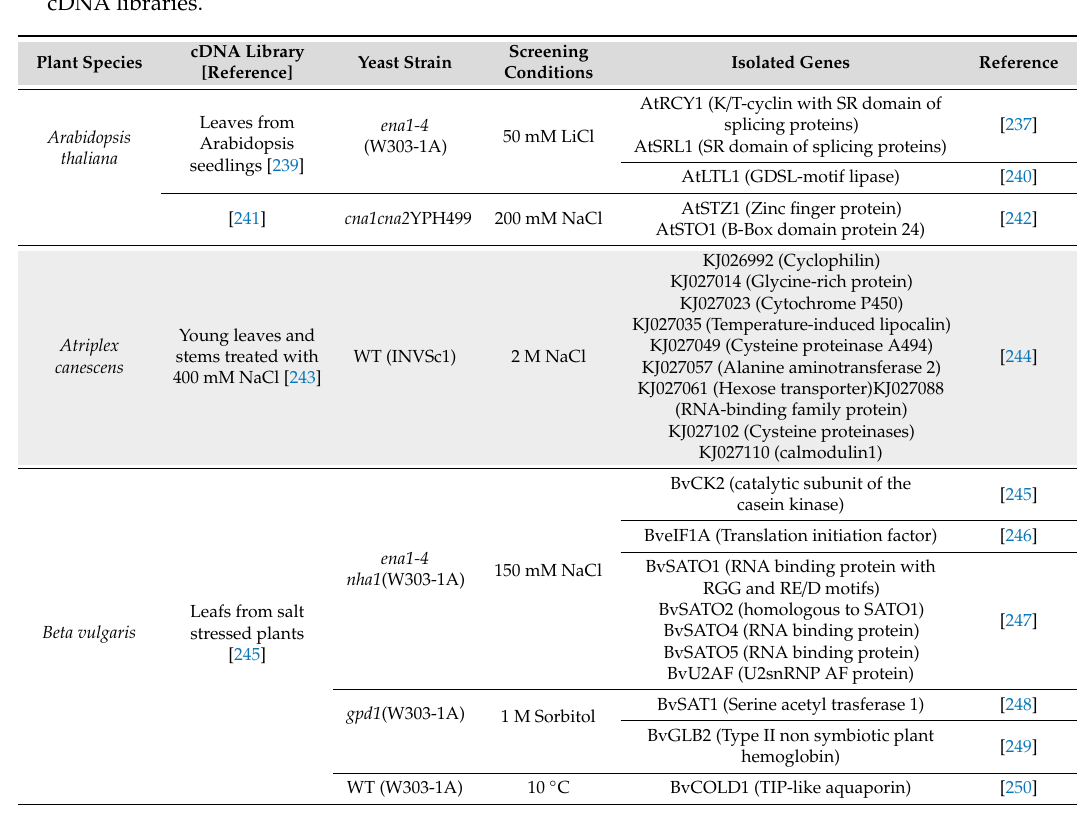
Table 7. A summary of the heterologous overexpression screenings performed in yeast using plant cDNA